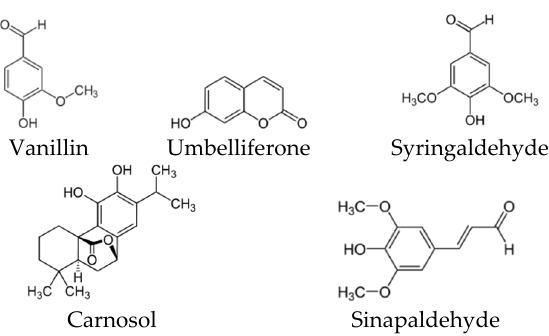
Figure 6. Flavonoids have been reported in different types of SBH.